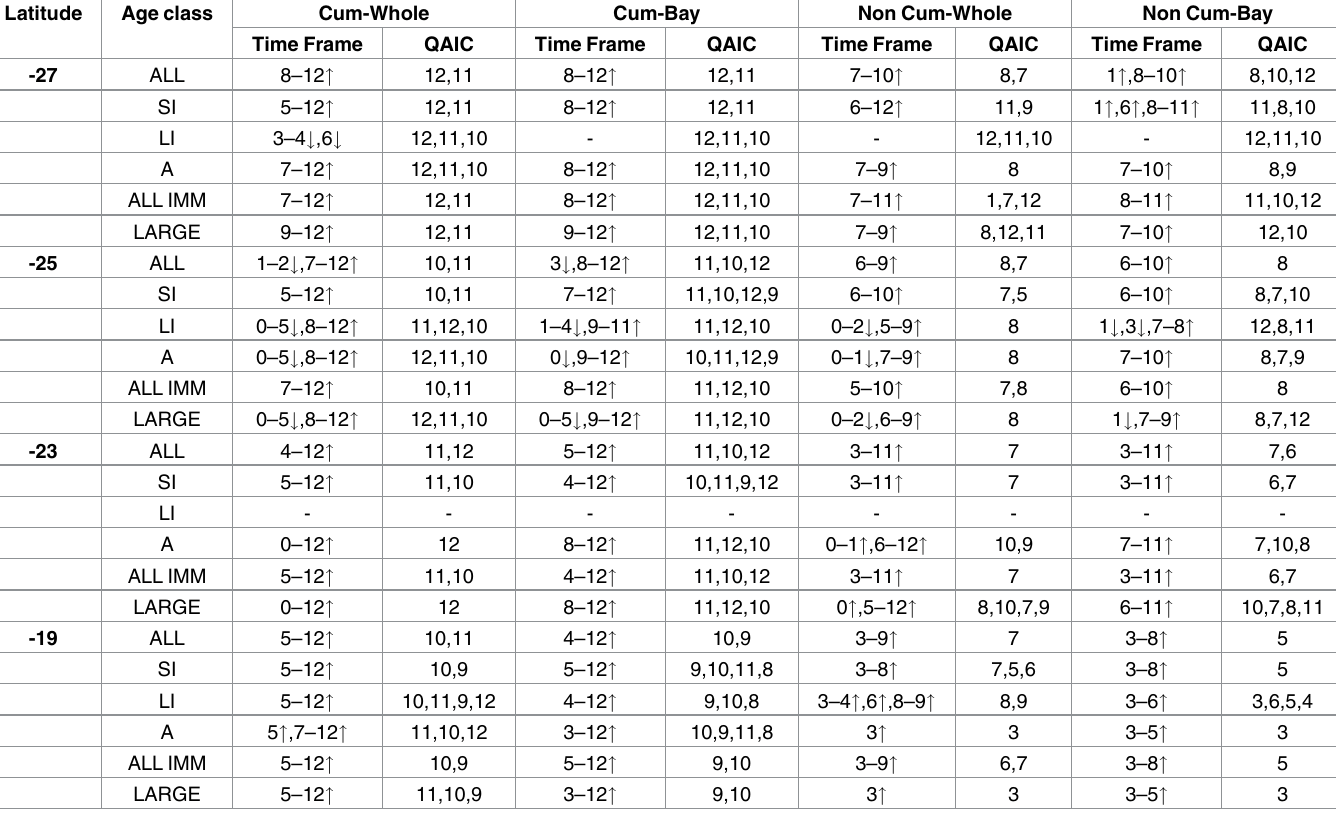
Table 12. Model results for all turtles peak discharge. " denotesincreasedstrandings rates with increaseddischarge. # denotesdecreased stranding rates with increaseddischarge.Age class abbreviations:ALL = all turtles, SI = small immature, LI = large immatures, A = adult-sized, ALL IMM = all immature sized animals(small + large), Large = all large turtles (large immatures + adult-sized). The time frame is reportedin monthly ranges where responses were noted. The values reported in qAIC are the months with the most significantqAIC